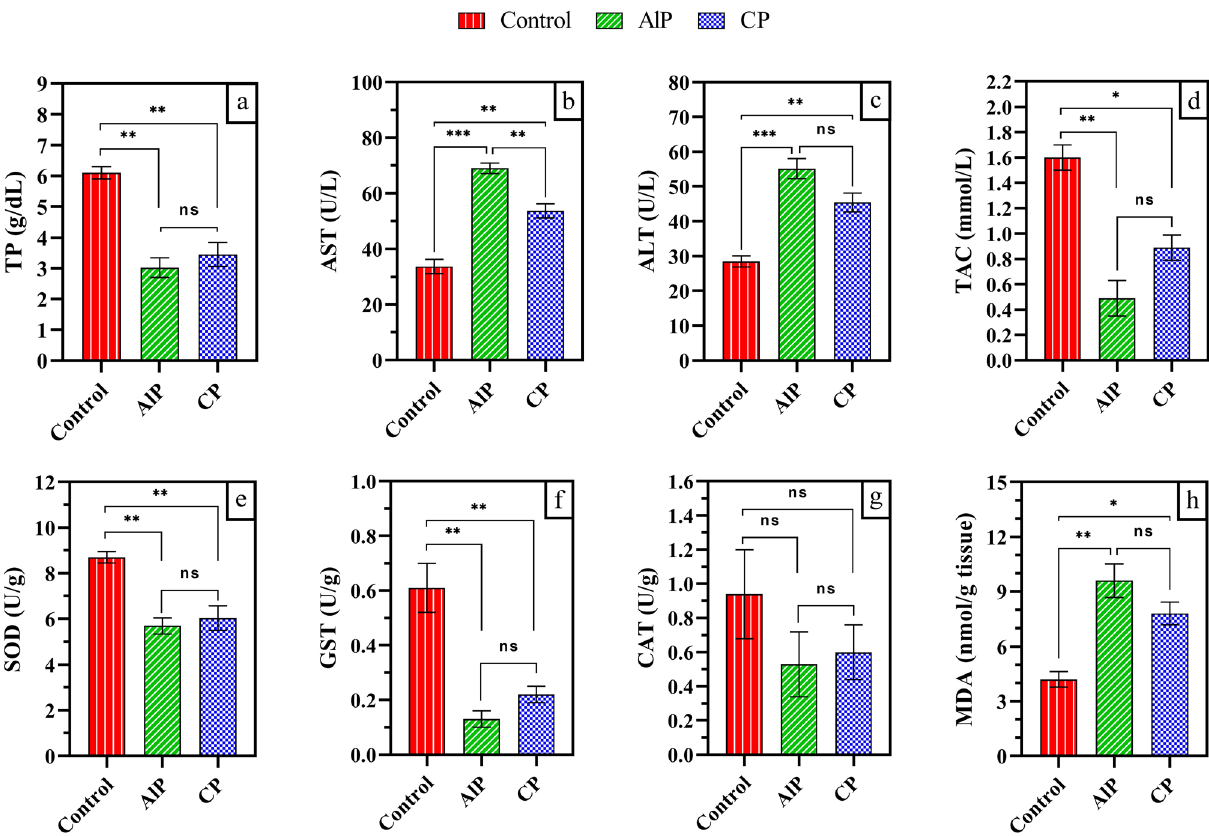
Figure 1. Impact of aluminum phosphide (AlP) and cypermethrin (CP) pesticides on the biochemicals parameters of Chrysomya megacephala . ( a ) total protein (TP); ( b ) aspartate aminotransferase (AST); ( c ) alanine aminotransferase (ALT); ( d ) total Antioxidant Capacity; ( e ) superoxide dismutase (SOD); ( f ) glutathione S- transferase (GST); ( g ) catalase (CAT); ( h ) total lipid peroxidation (MDA). *p < 0.05; **p < 0.01; ***p < 0.001; ns not